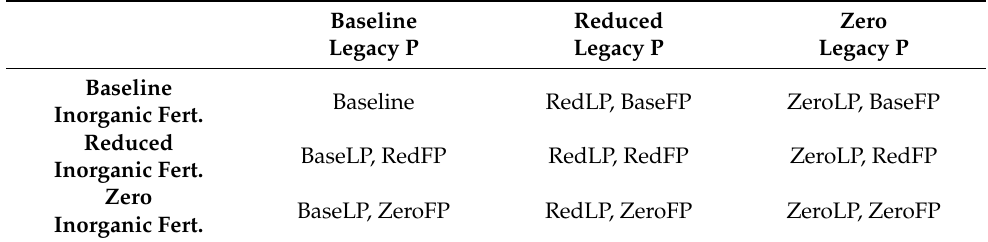
Table 2. Summary of Alternative Scenarios formulated to quantify the contributions of various P sources from the TCNS to TP loads into Lake Okeechobee.